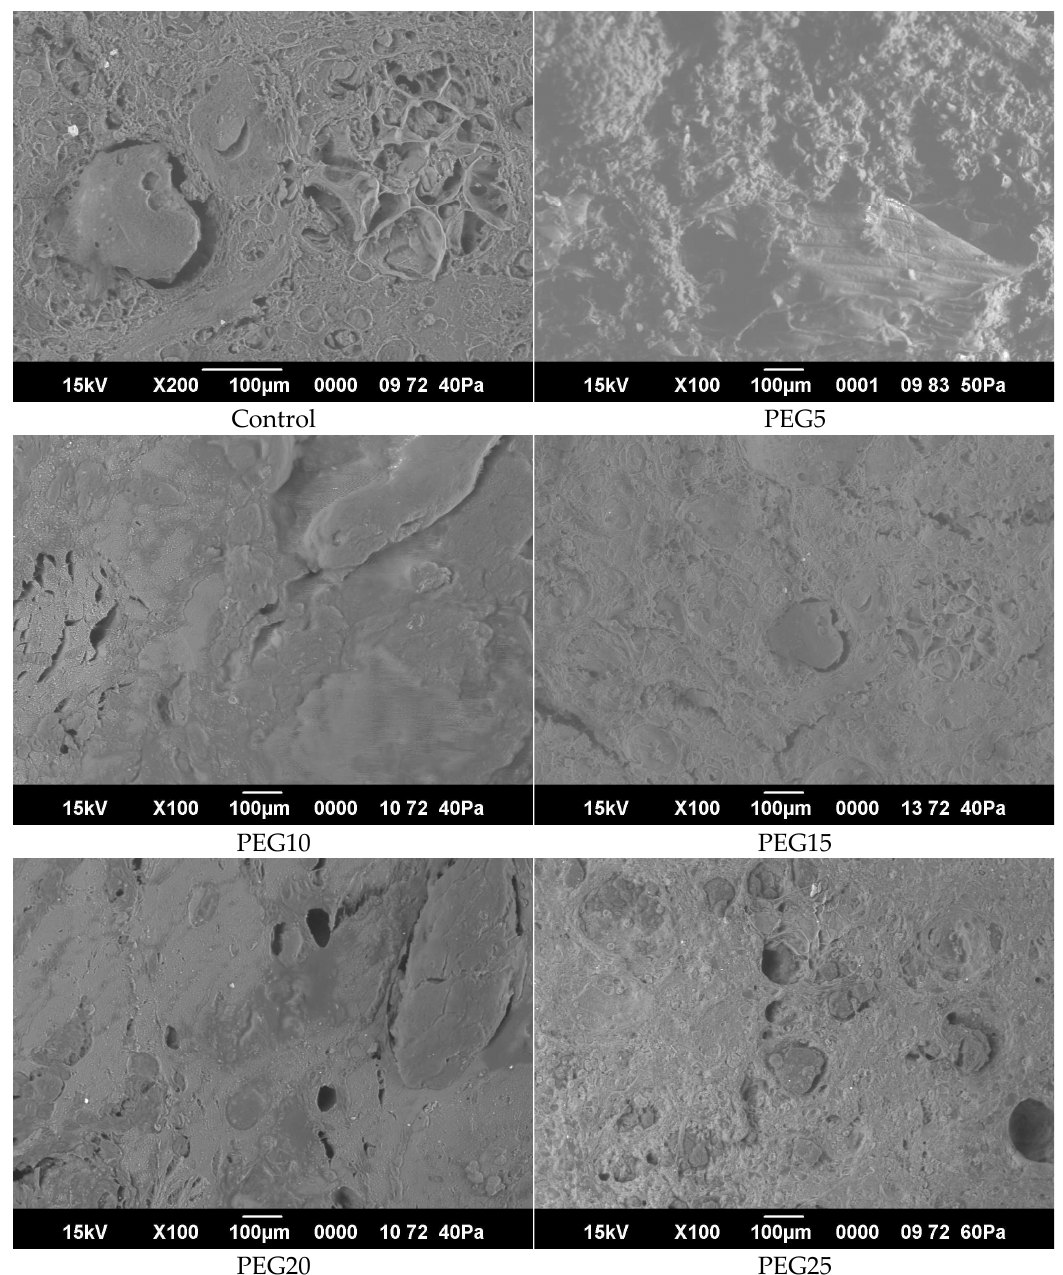
Figure 3. SEM images of semi ‐ smoked sausages with different level of